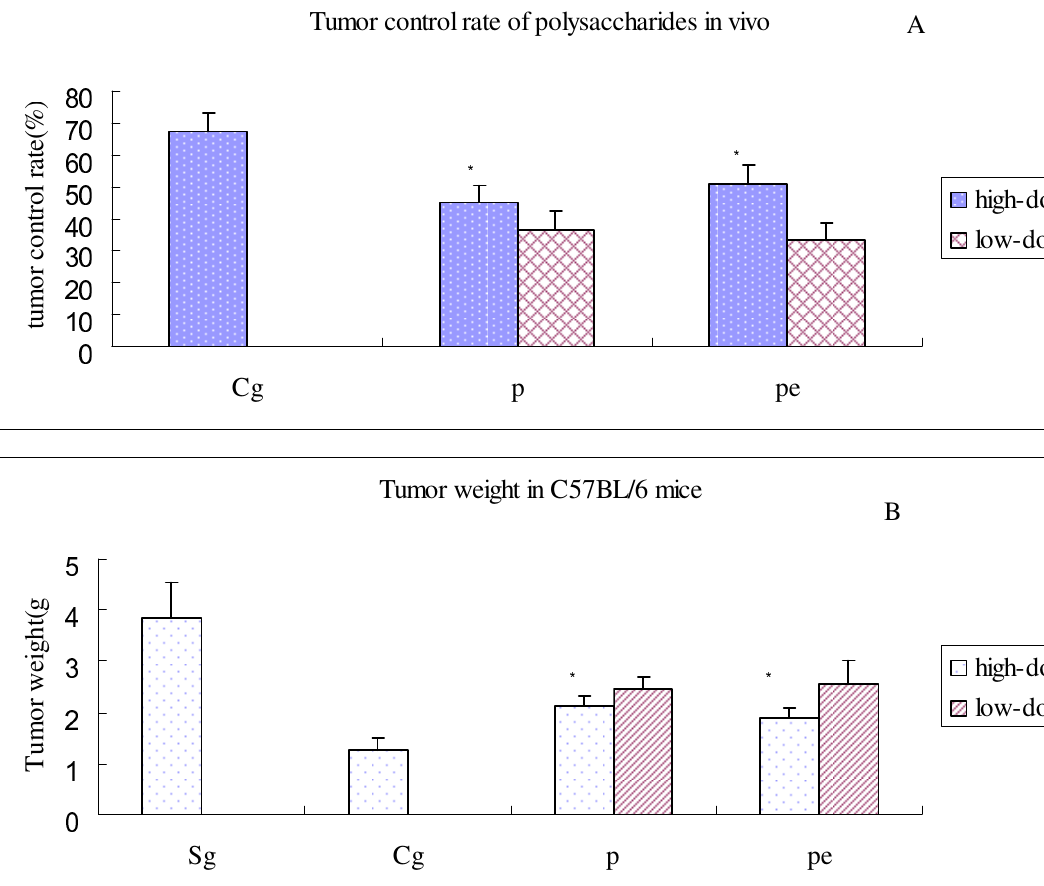
Figure 6. Tumor inhibitory rate of polysaccharide P32 in the C57BL/6 mice. Tumor control rate of polysaccharides in